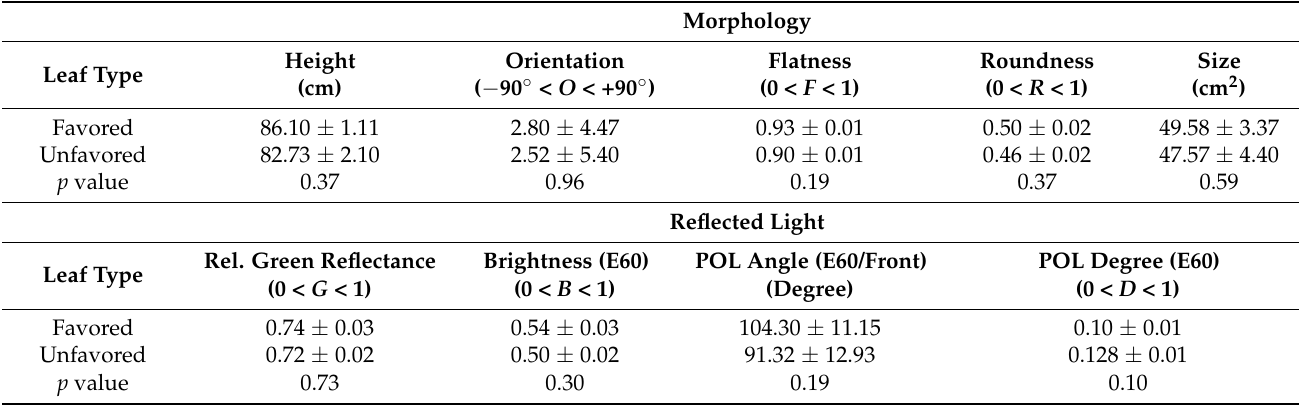
Table 1. Five morphological and four reflective features of favored and unfavored leaves (25 leaves for each type). Mean value ( ± SE ) of twenty-five leaves for favored and unfavored leaves. p value is obtained by Wilcoxon ranked sum test.